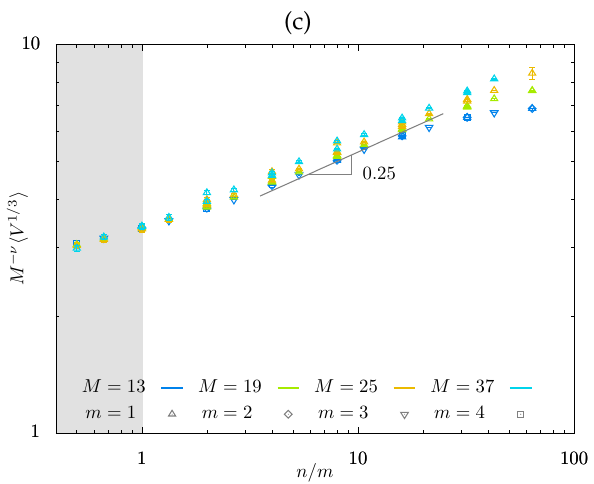
1/3 and end-to-end distances of the side chains V (cid:104) (cid:105)